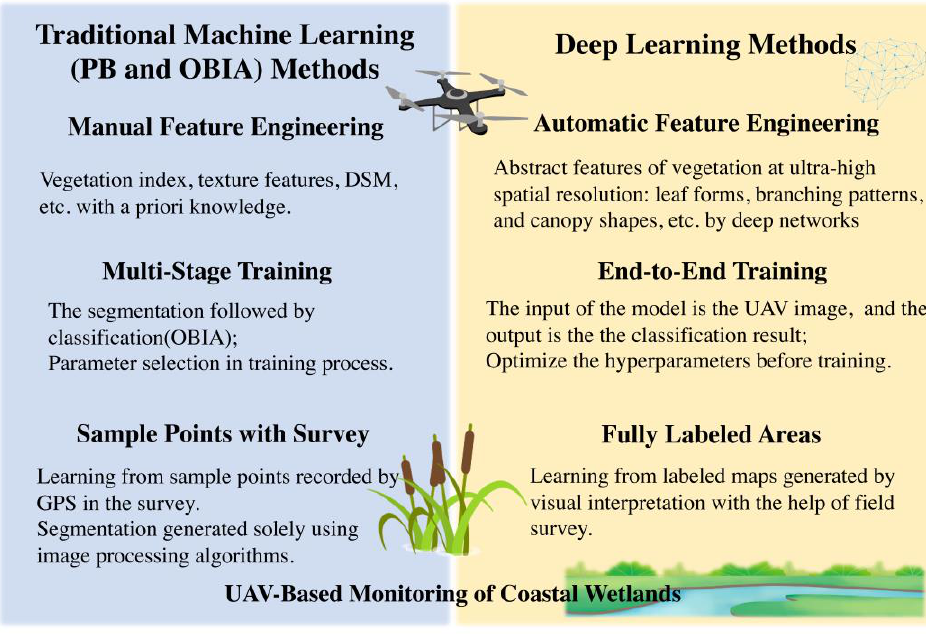
Figure 8. Paradigm shift between PB, OBIA, and DL methods in terms of feature engineering, training methods, and reference data.